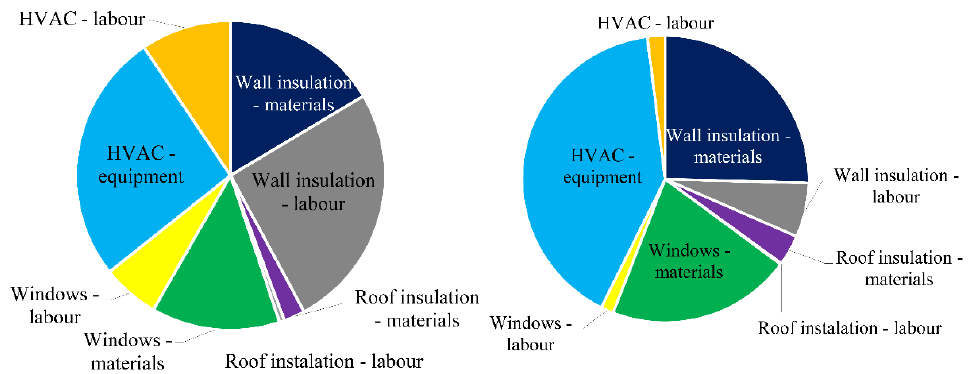
Figure 5. The structure of the costs for DR for two countries with the most extreme differences in the cost of manpower — Germany ( left ) and Serbia ( right ) for 30-0.6-50 case.